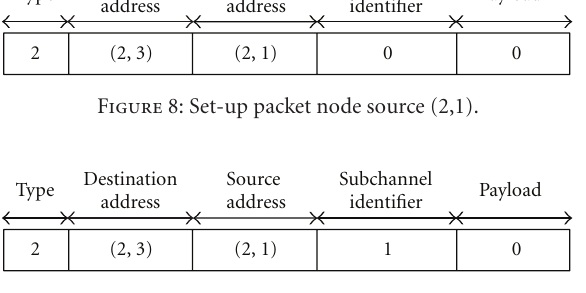
Figure 9: Incoming set-up packet allocator EAST (2,2).